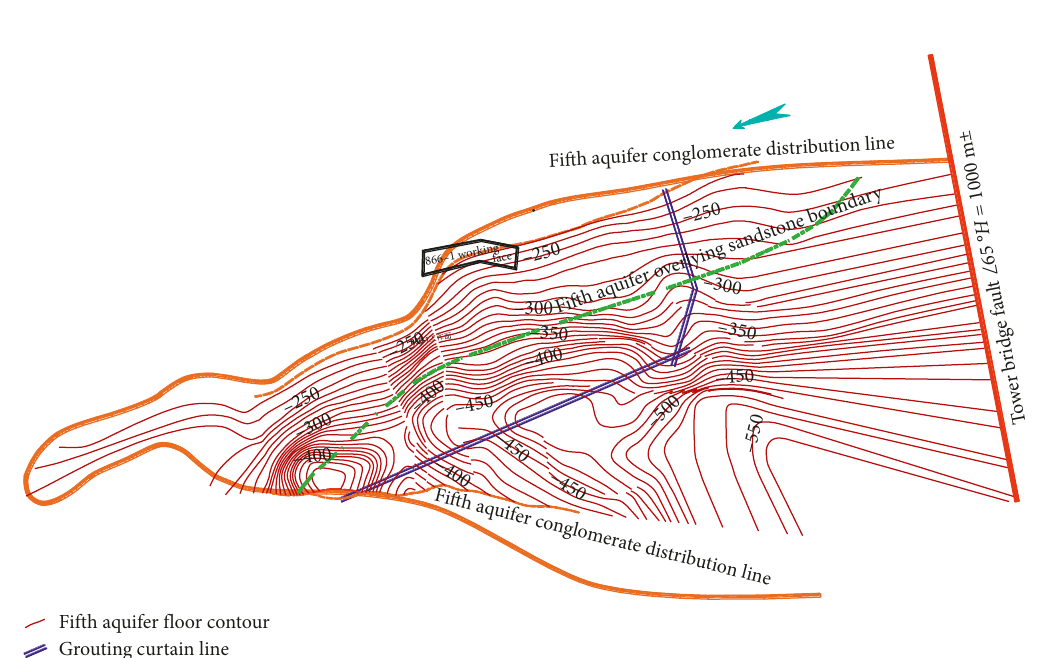
Figure 4: The engineering design plan of the “L”-shaped curtain blocking the fifth